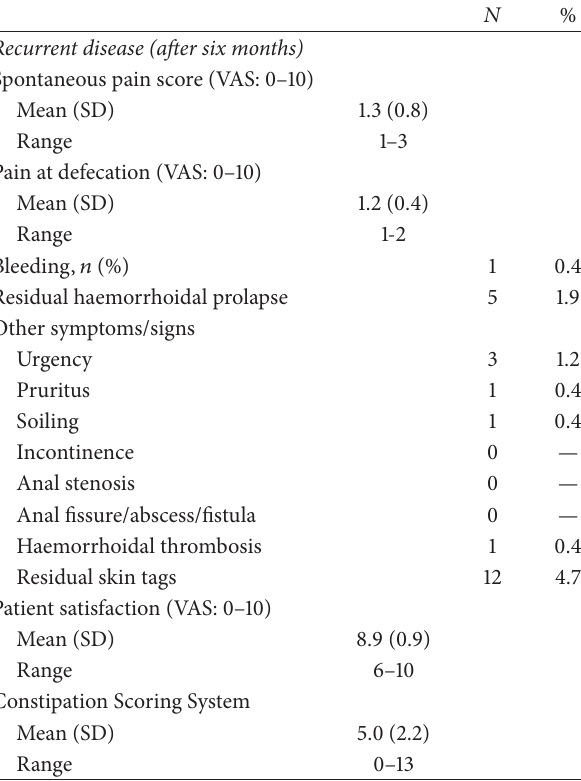
Table 4: Follow-up at six months in 430 patients. Residual disease (within six months)